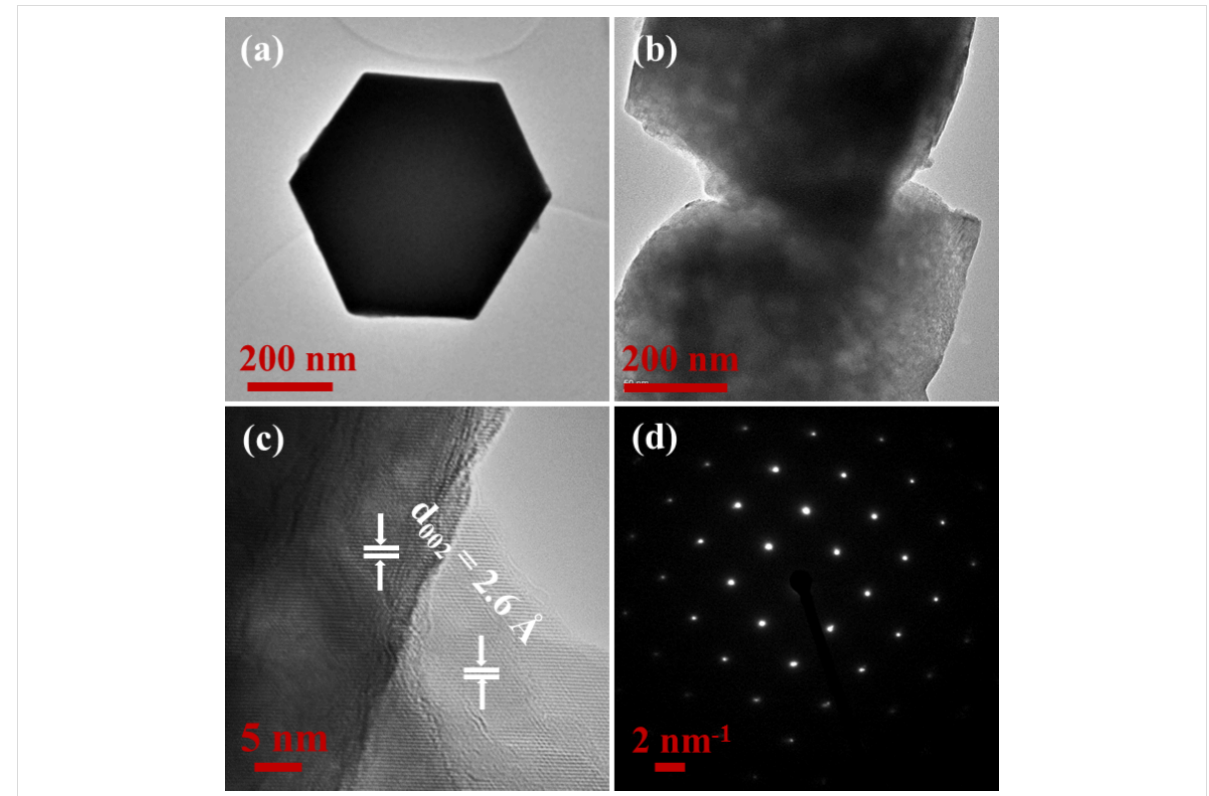
Figure 4: Microstructure characterization of hexagonal-shaped twinned ZnO NCs for the S600 sample. (a, b) Low-resolution TEM image, (c) high- resolution TEM image, and (d) selected area electron diffraction